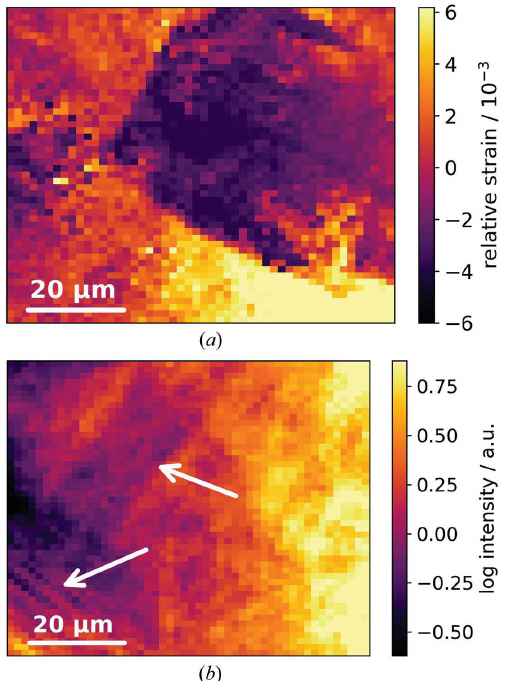
Figure 3 ( a ) Strain (cid:8) 200 as a function of sample according to equation (2). ( b ) Intensity [ C + H in equation (1)] of the (310) reflection showing lamella-like martensite structure. Although the images show the same area of the sample, the visible information relating to the two different reflections is complementary and originates from different structures.